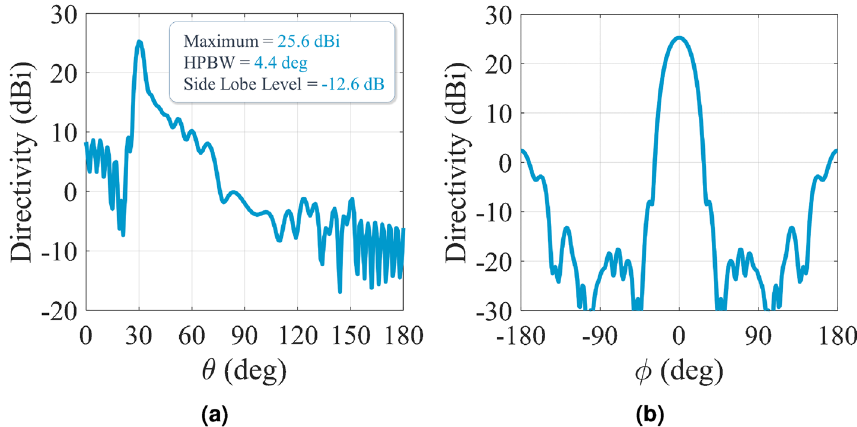
Figure 6. Simulated radiation patterns of the proposed hologram in Fig. 5 at: ( a ) φ = 0 ◦ and ( b ) θ = 30 ◦ planes. The operation frequency is 18 GHz.